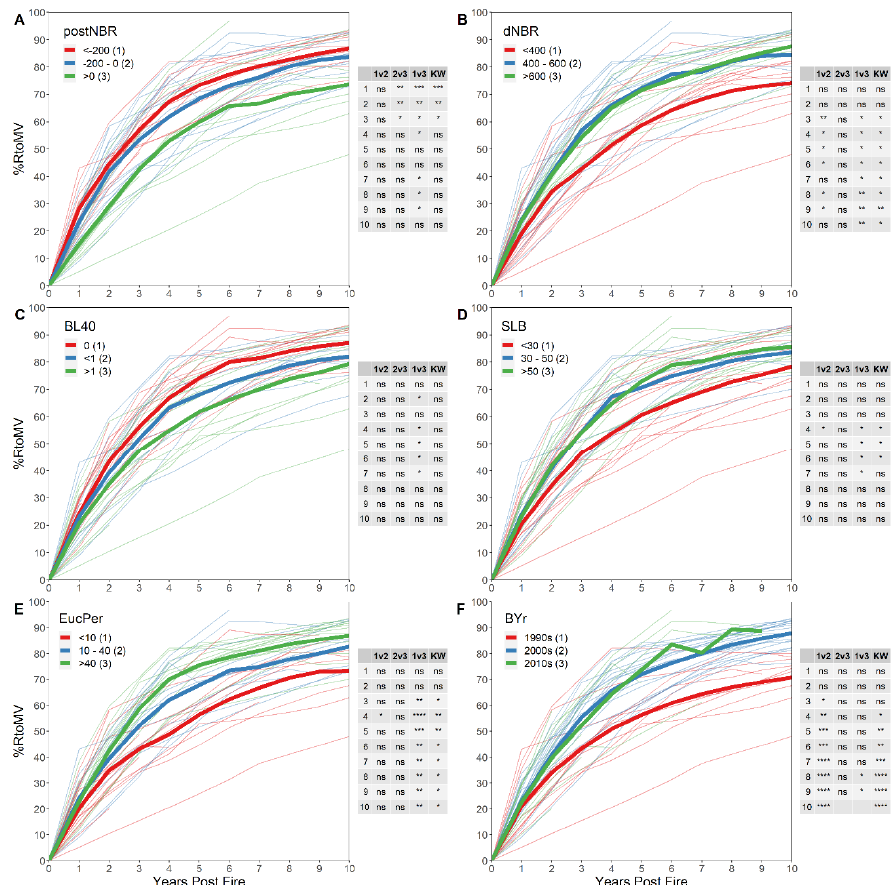
Figure 13. Relationship between variables that improved model performance and %RtoMV for the first 10 years post-fire. ( A ) postNBR , ( B ) dNBR , ( C ) BL40, ( D ) SLB, ( E ) EucPer (% Eycalypt woodlands vegetation group), ( F ) BYr. See Table 3 for full variable names and descriptions. Each time-series shows fires split into groups based on differences within each variable. MW between group test significance is shown in a table next to each plot and is based on numbers in each legend. KW overall test significance is shown in the far-right column.